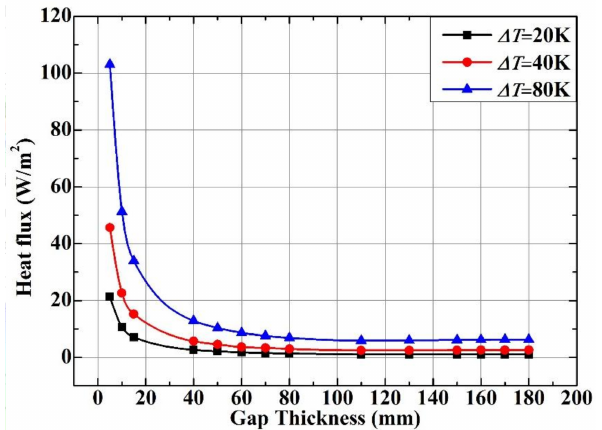
Figure 8. Variation in heat flux with the vertical enclosure gap thickness.